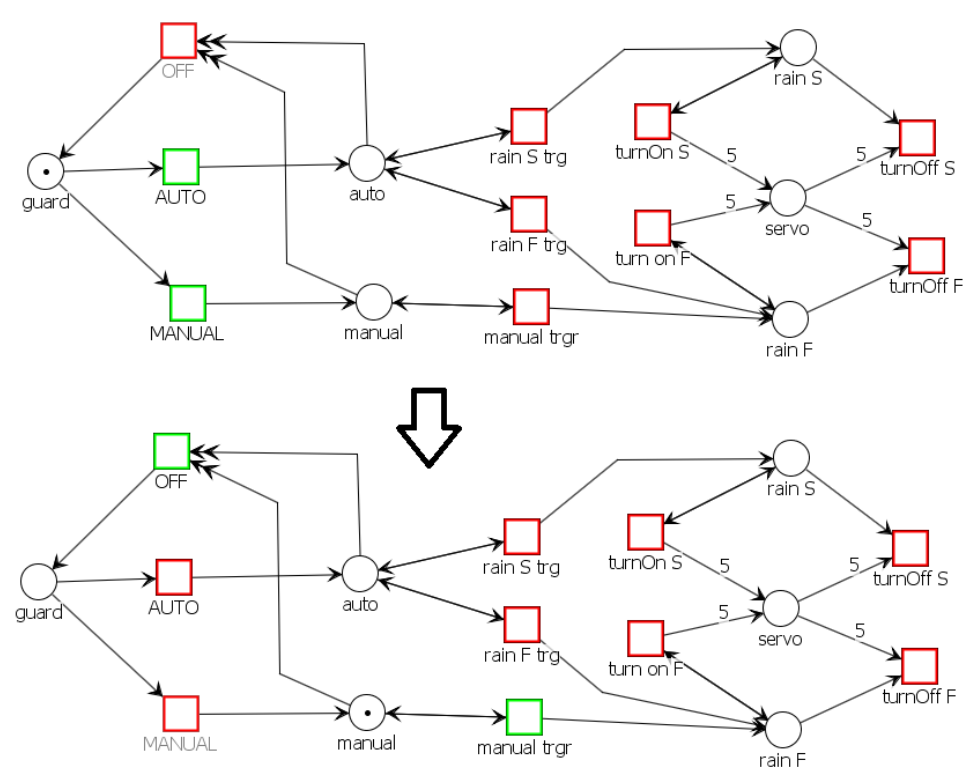
Figure 12. Petri net for control of laboratory car wiper system–initial marking and marking after starting manual mode.